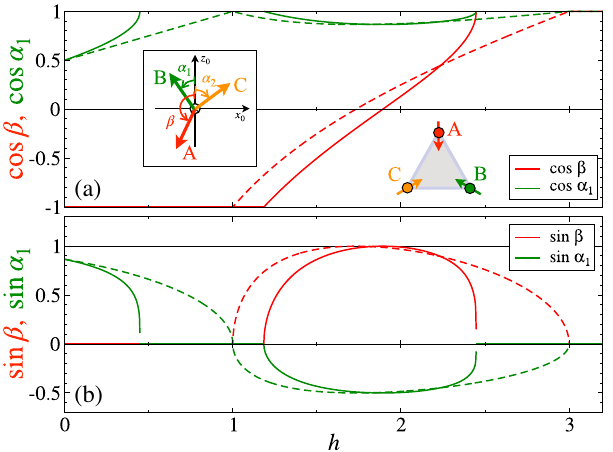
FIG. 12. (a) Cosines and (b) sines of angles α 1 and β vs h throughout the Y-UUD-V-FM sequence of the phases in Fig. 4, h ¼ g μ H= 3 J 1 S . Dashed lines are for the pure Heisenberg B model, b ¼ 0 ; solid lines are for b ¼ BS 2 =J 1 ¼ 0 . 0922 from Table I. Small discontinuities due to very weakly first-order transitions can be seen at the Y-UUD and V-FM transitions, 1 = 11 ≈ 0 . 0909 as b ¼ 0 . 0922 > b c ¼